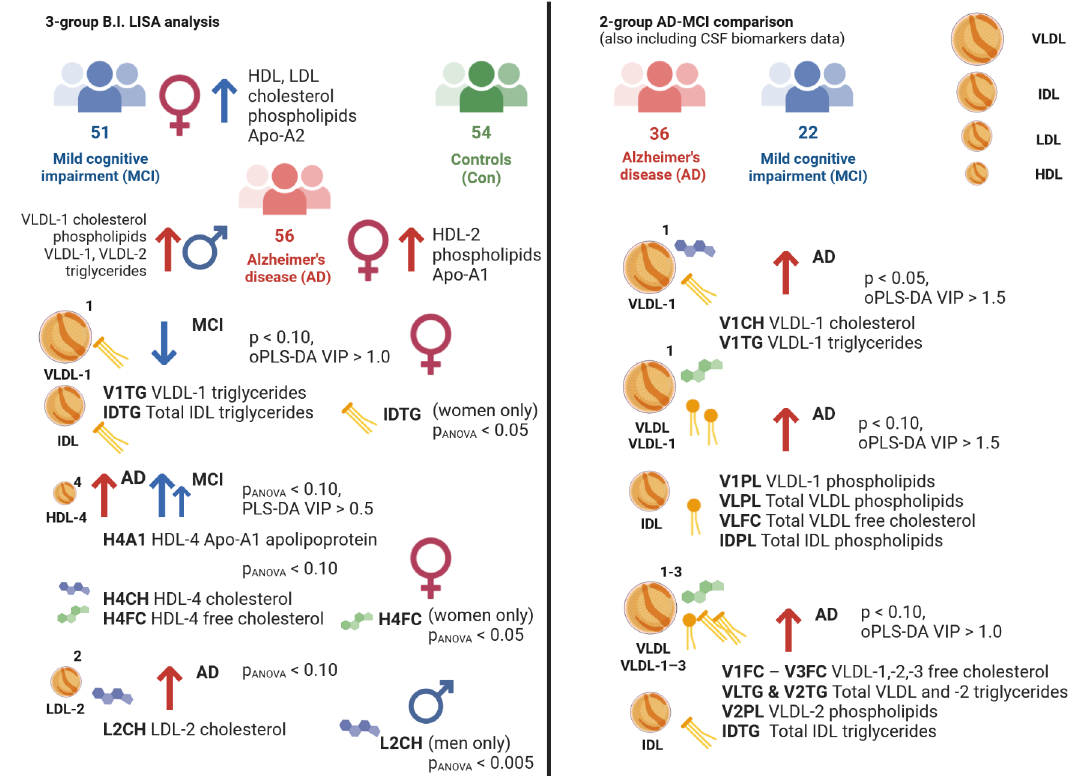
Figure 4. Graphical summary of the results presented in this study.